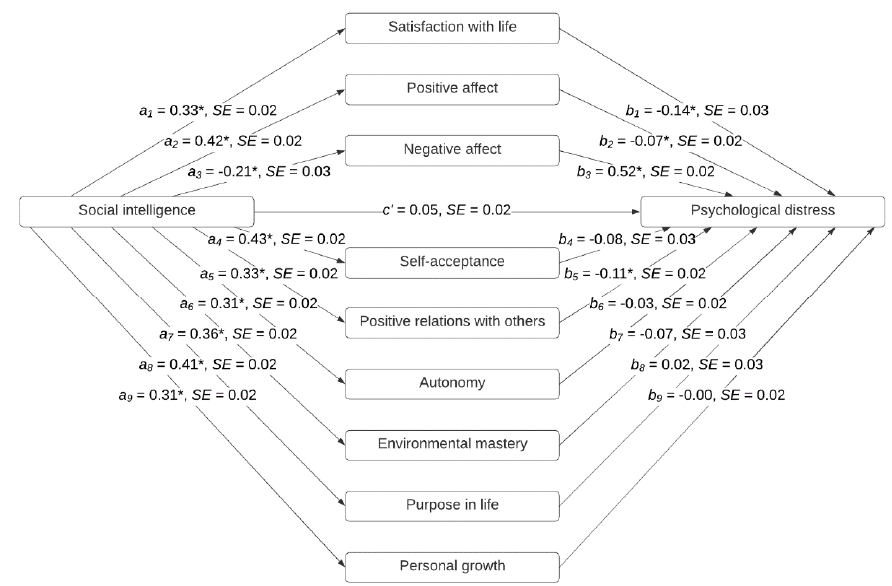
Figure 1. Parallel multiple mediator model of social intelligence, subjective well-being, psychological well-being, and psychological distress. Standardized coefficients and standard errors ( SE ) are shown in the figure. * p < 0.001.